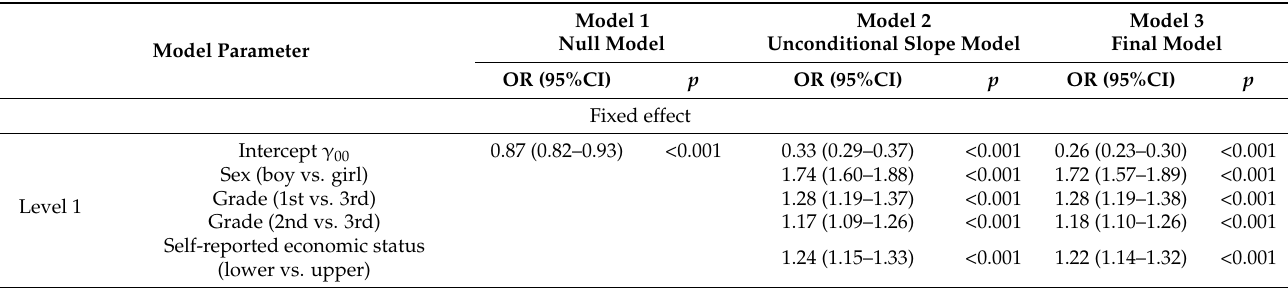
Table 3. Multilevel analysis of students who brush twice a day or